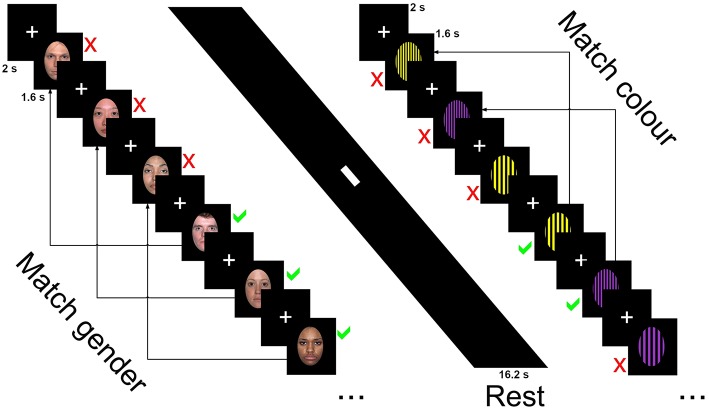
Stimuli presentation sequence for the 3-back task showing neutral faces, rest, and horizontal grating conditions.